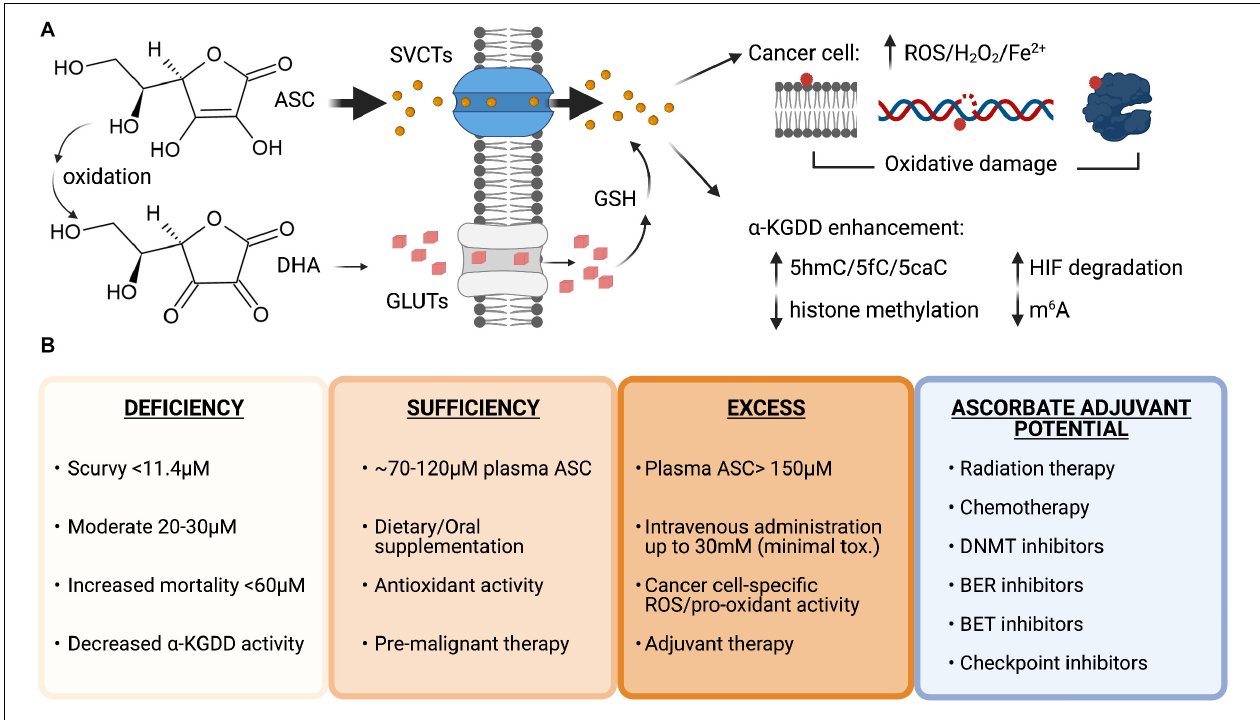
FIGURE 3 | Vitamin C uptake and therapeutic potential as an anti-cancer agent. (A) Structures of ascorbate (ASC) and dehydroascorbate (DHA). ASC primarily enters cells through sodium-dependent vitamin C transporters (SVCTs) and can be transported in its oxidized form as DHA via glucose transporters (GLUTs) then reduced back to ASC by the antioxidant glutathione (GSH) once inside the cell. ASC can enhance the activity of α -ketoglutarate dependent dioxygenases ( α -KGDD), and high doses can act as a pro-oxidant, creating increased levels of reactive oxygen species (ROS), H2O2 and increased redox active iron levels (Fe 2 + ) that cause lipid, DNA, and protein oxidation in cancer cells. (B) Plasma ascorbate levels correlate with disease states, overall health, and therapeutic potential. Ascorbate deficiency is associated with increased all-cause mortality and lower α -KGDD activity. Oral supplementation can restore plasma levels to normal and allow vitamin C antioxidant properties to provide benefit as a pre-malignant therapy potentially lowering genomic instability and preventing transformation. High-dose intravenous administration of ASC can be used to generate millimolar (mM) plasma concentrations and generate ROS and pro-oxidant damage to cancer cells. Vitamin C has currently shown efficacy as an adjuvant for many cancer therapies in pre-clinical and clinical trials in combination with standard chemotherapy, DNA hypomethylating agents and targeted inhibitors: Carboplatin and Paclitaxel, Azacitidine, poly-adenosine diphosphate-ribose polymerase (PARP) inhibitors (Olaparib), immune checkpoint inhibitors (anti-PD1 and anti-CTLA4), and bromodomain and extraterminal domain (BET) inhibitors (JQ1). Figure created with